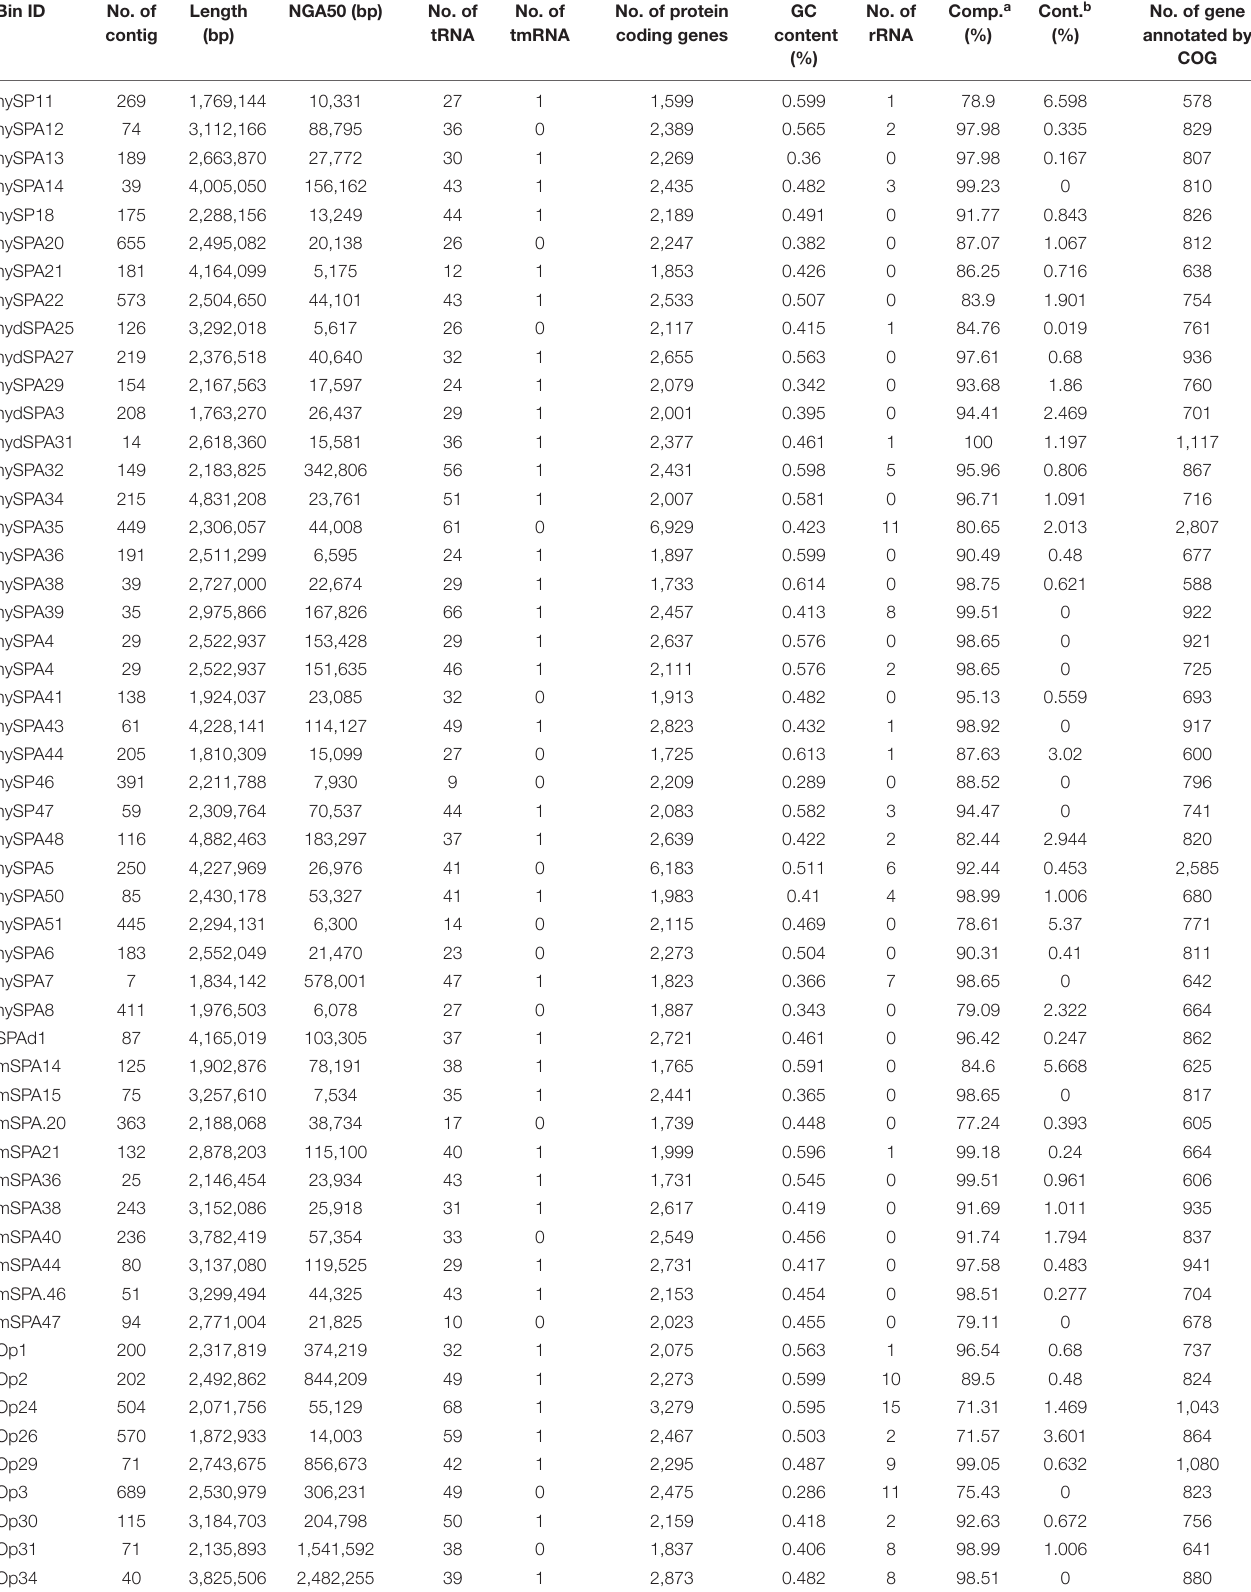
TABLE 3 | General genomic features of all bins reconstructed from dereplication of metagenome assembly with different algorithms. Bin